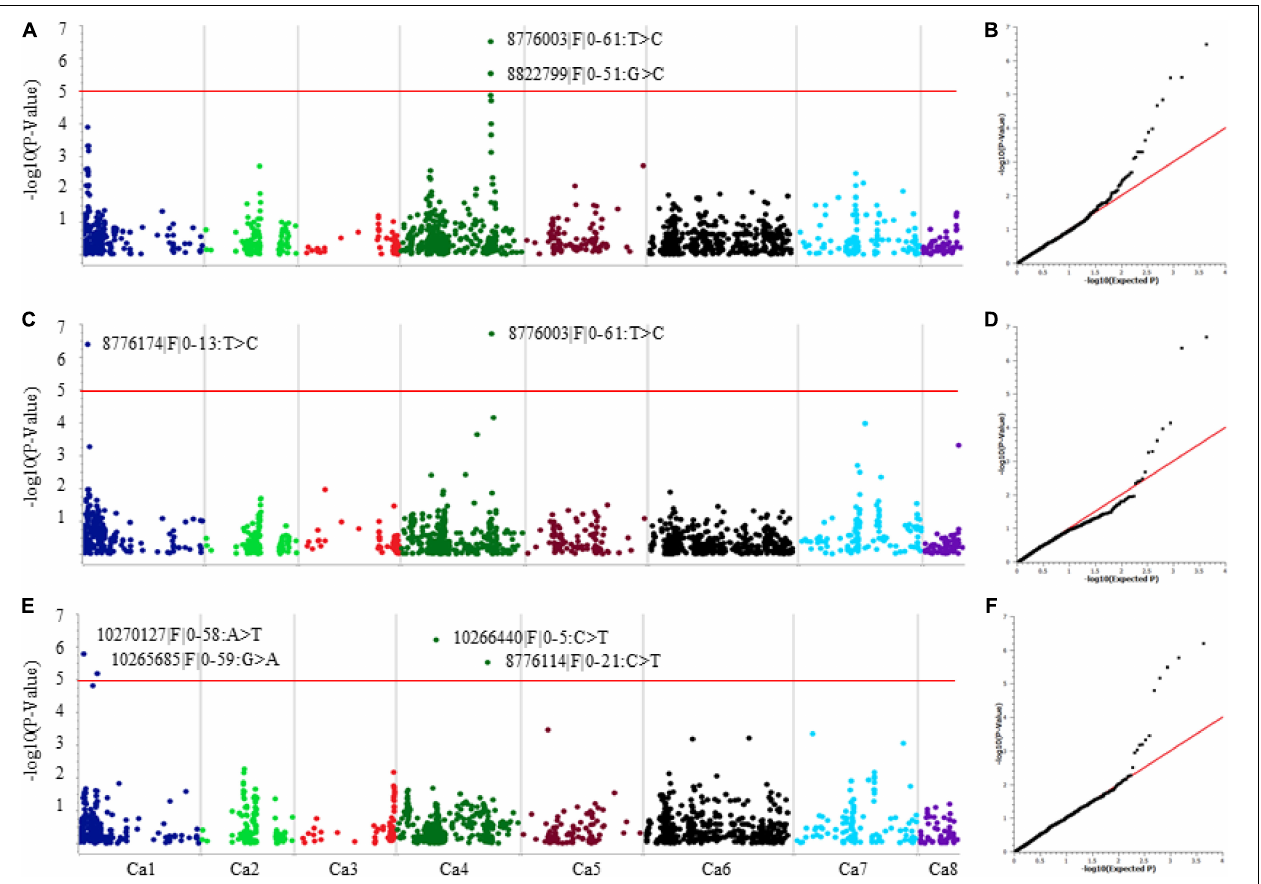
FIGURE 3 | Manhattan and quantile–quantile (Q–Q) plots showing association of significant SNP with resistance to A. rabiei (A,B) Isolate F17191-1 using SLMM. (C,D) Isolate F17191-1 using MLMM. (E,F) Isolate TR9571 using MLMM. For Manhattan plots, the X-axis represents SNP positions across the eight chickpea chromosomes and the Y-axis is the negative logarithm p -value: –log10 ( p ) of each SNP. For Q–Q plots, X-axis represents expected –log10 ( p ) and Y-axis is observed –log10 ( p ) for each